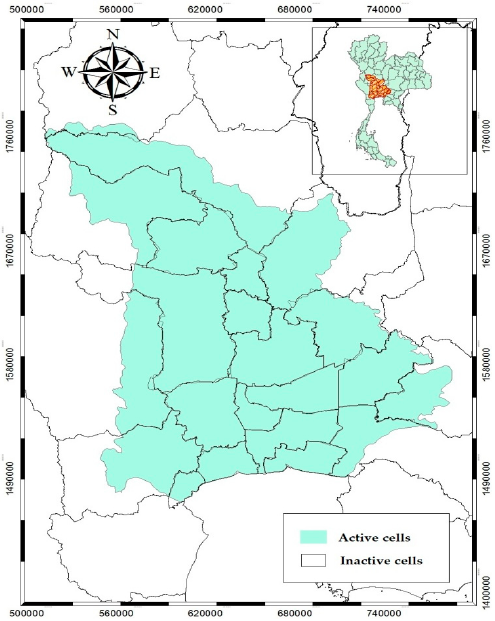
Figure 6. Study area and the no-flux boundary. Table 1. Mean hydraulic heads of the aquifers.